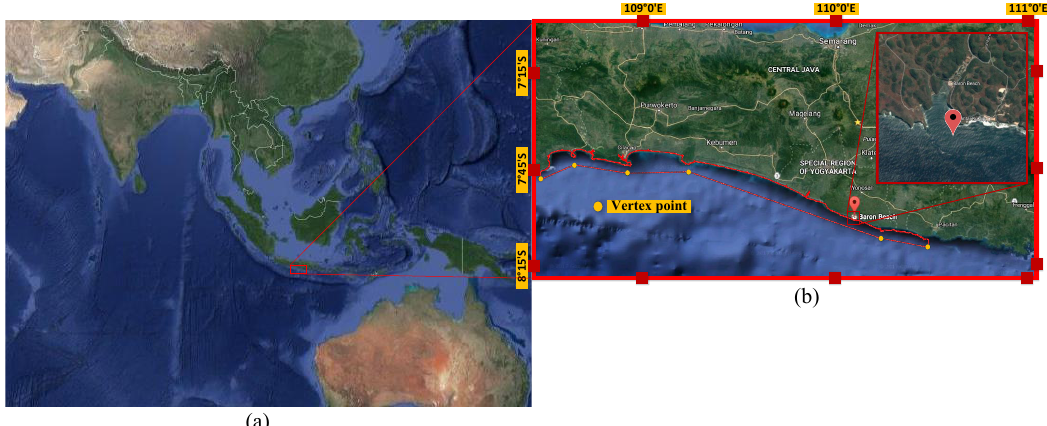
Figure 1. The map of the study area and the location of the Baron’s buoy observation station ( a ); The segmented domain and its vertices ( b